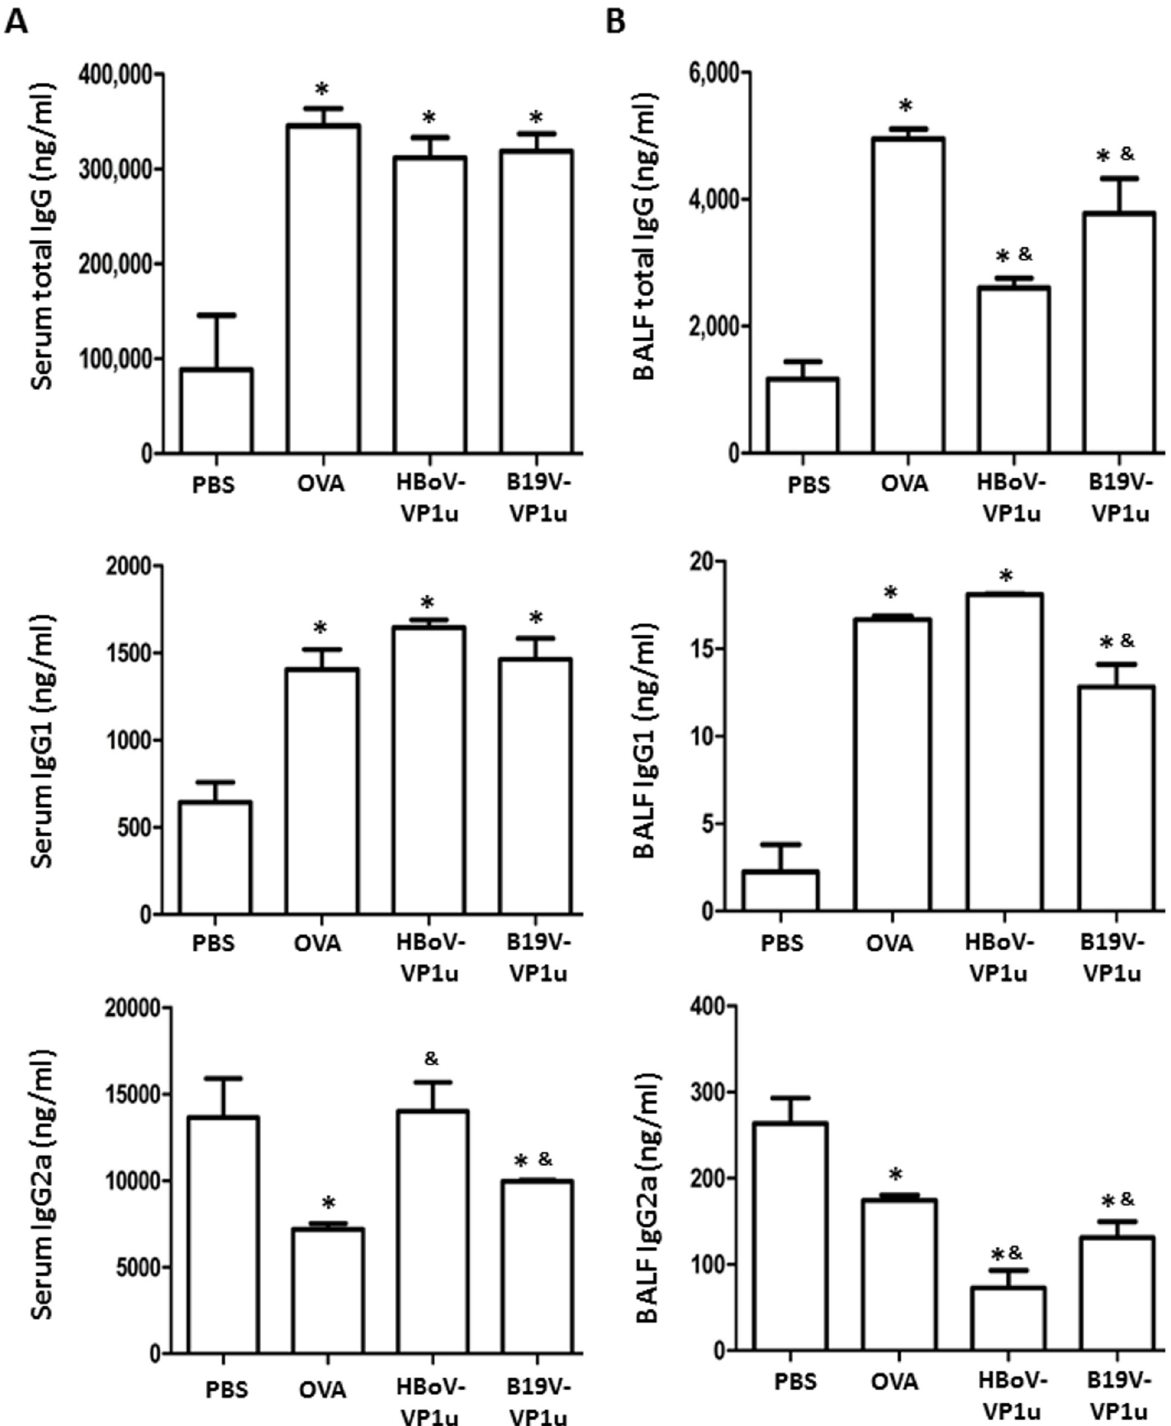
Fig 3. The levels of IgG subtypes. The total IgG, IgG1 and IgG2a in (A) serum and (B) BALF was measured in mice from PBS, OVA, HBoV-VP1u and B19V-VP1u groups. Values are mean ± SD. Similar results were observed in three repeated experiments. � and & indicate significant difference, p < 0.05, relative to PBS and OVA groups, respectively. (n = 5 for each group).